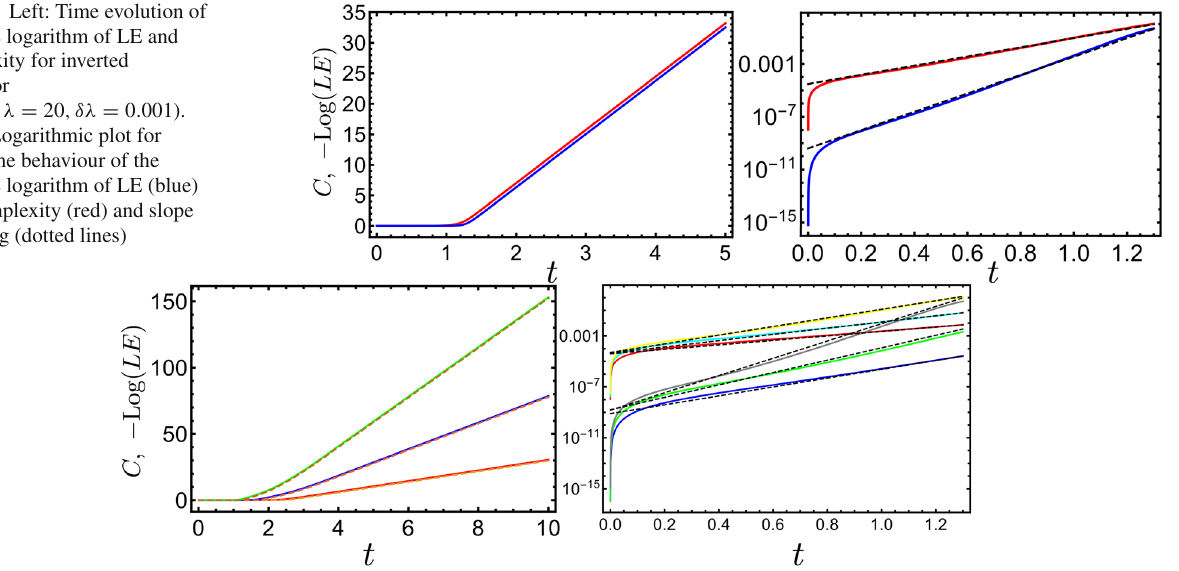
Fig. 13 Left: Time evolution of negative logarithm of LE and complexity for inverted oscillator ( m = 1 ,λ = 20 ,δλ = 0 . 001). Right: Logarithmic plot for early time behaviour of the negative logarithm of LE (blue) and complexity (red) and slope matching (dotted lines)